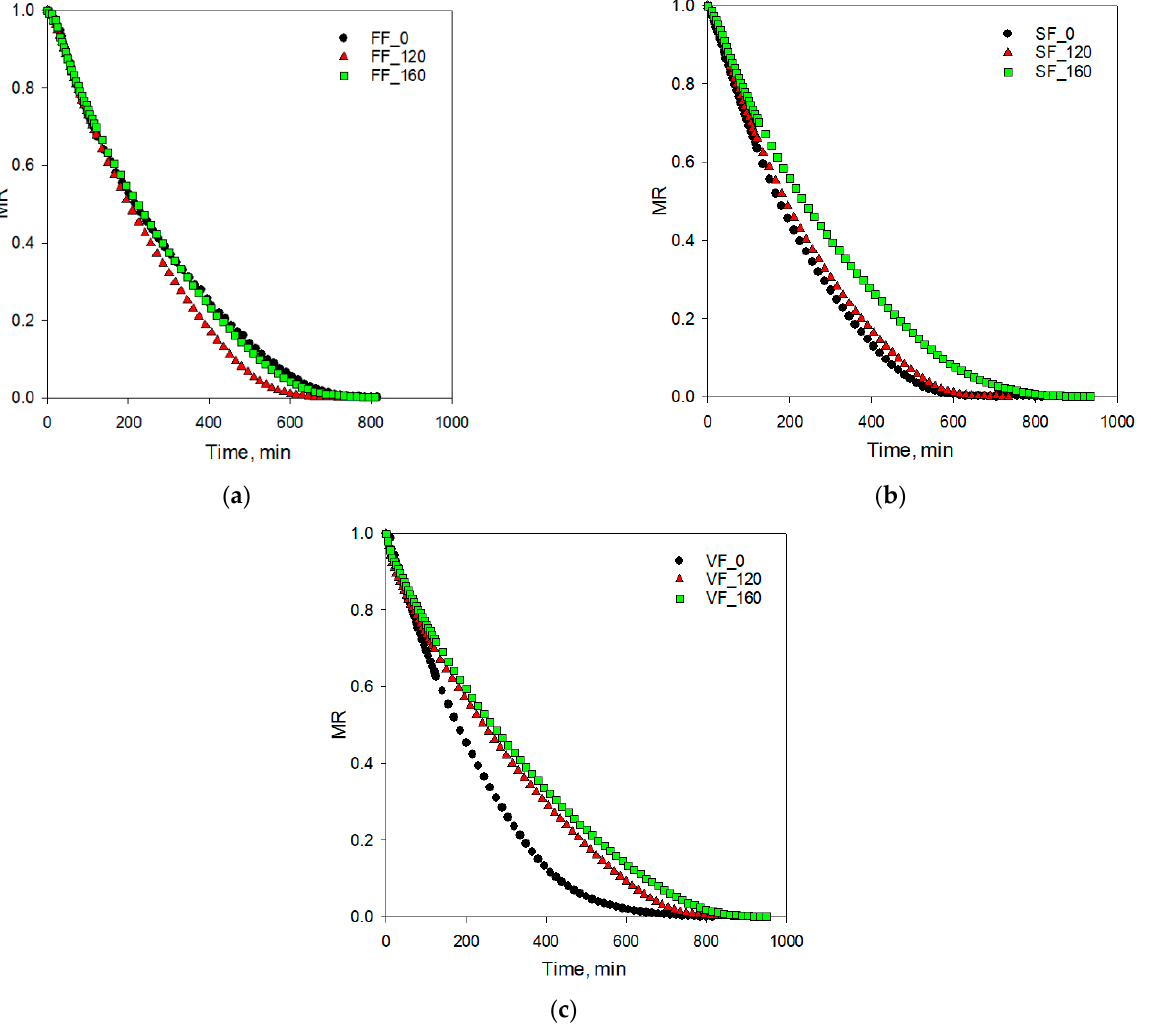
Figure 2. Experimental drying curves of apples with and without PEF treatment: ( a ) fast-frozen FF, ( b ) slow-frozen SF, ( c ) vacuum-frozen VF.